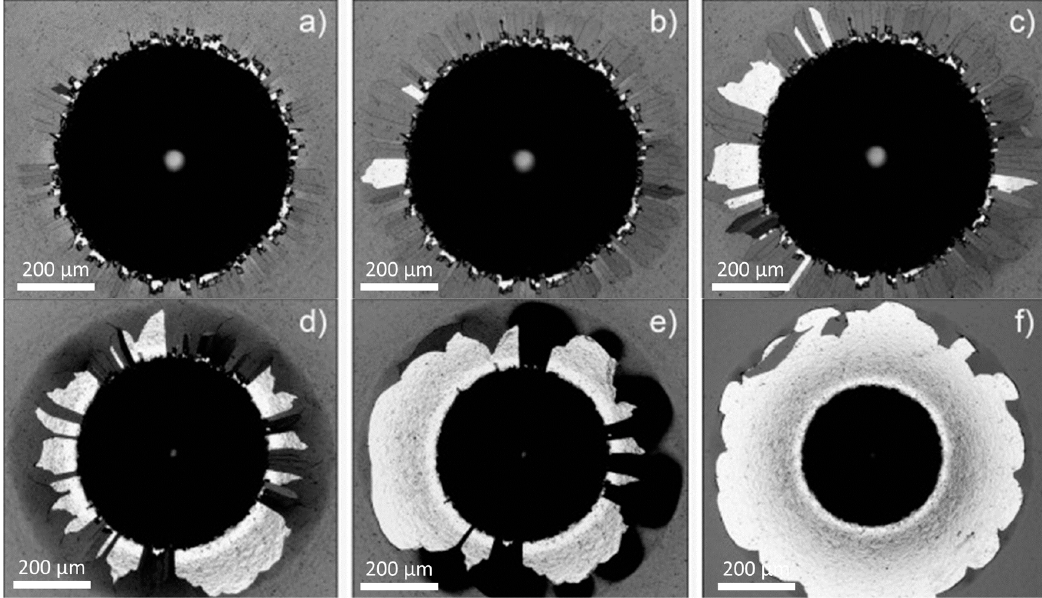
Figure 12. Delamination area evolution of 2 µm-thick DLC coating on CoCrMo around Rockwell indentation using a load of 1500 N: ( a ) t = 0, ( b ) t = 15 min, ( c ) t = 65 min, ( d ) t = 4 h 25 min, ( e ) t = 16 h 50 min, ( f ) t = 160 h 40 min. Between immersions, the coating was immersed in PBS at 37 °C. Reproduced from [ 126 ] .